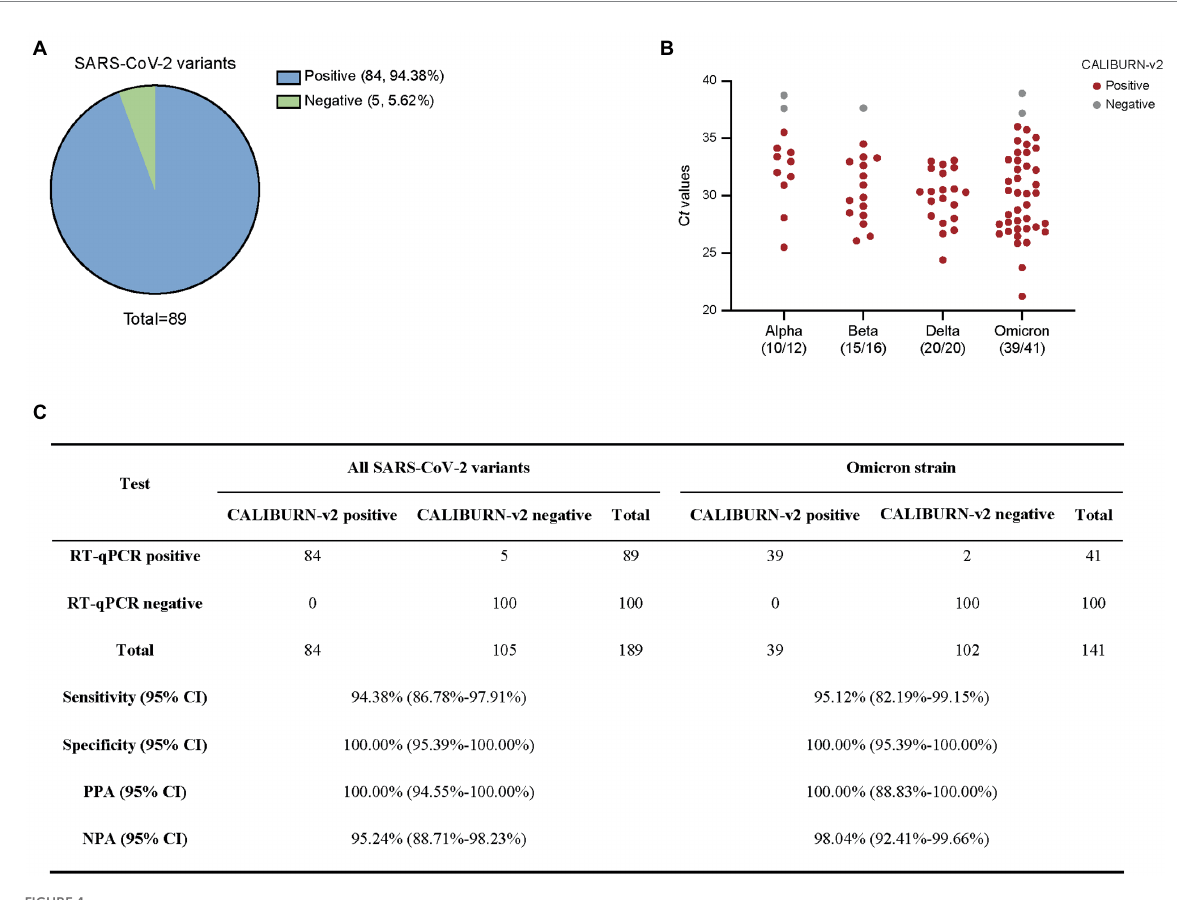
FIGURE 4 Detection of SARS-CoV-2 variants using smartphone-controlled CALIBURN-v2. (A) Overall sensitivity of CALIBURN-v2 on clinical nucleic acid specimens of SARS-CoV-2 variants. (B) Sensitivity of CALIBURN-v2 on different SARS-CoV-2 variants and the correlations with RT-qPCR C t values. The ratios of positive samples with each variants are indicated. C t values are obtained from the RT-qPCR assay for SARS-CoV-2 N gene. NTC, non- template control. (C) Concordance between RT-qPCR and CALIBURN-v2 for SARS-CoV-2 variant detection. PPA, positive predictive agreement; NPA, negative predictive agreement; CI, confidence